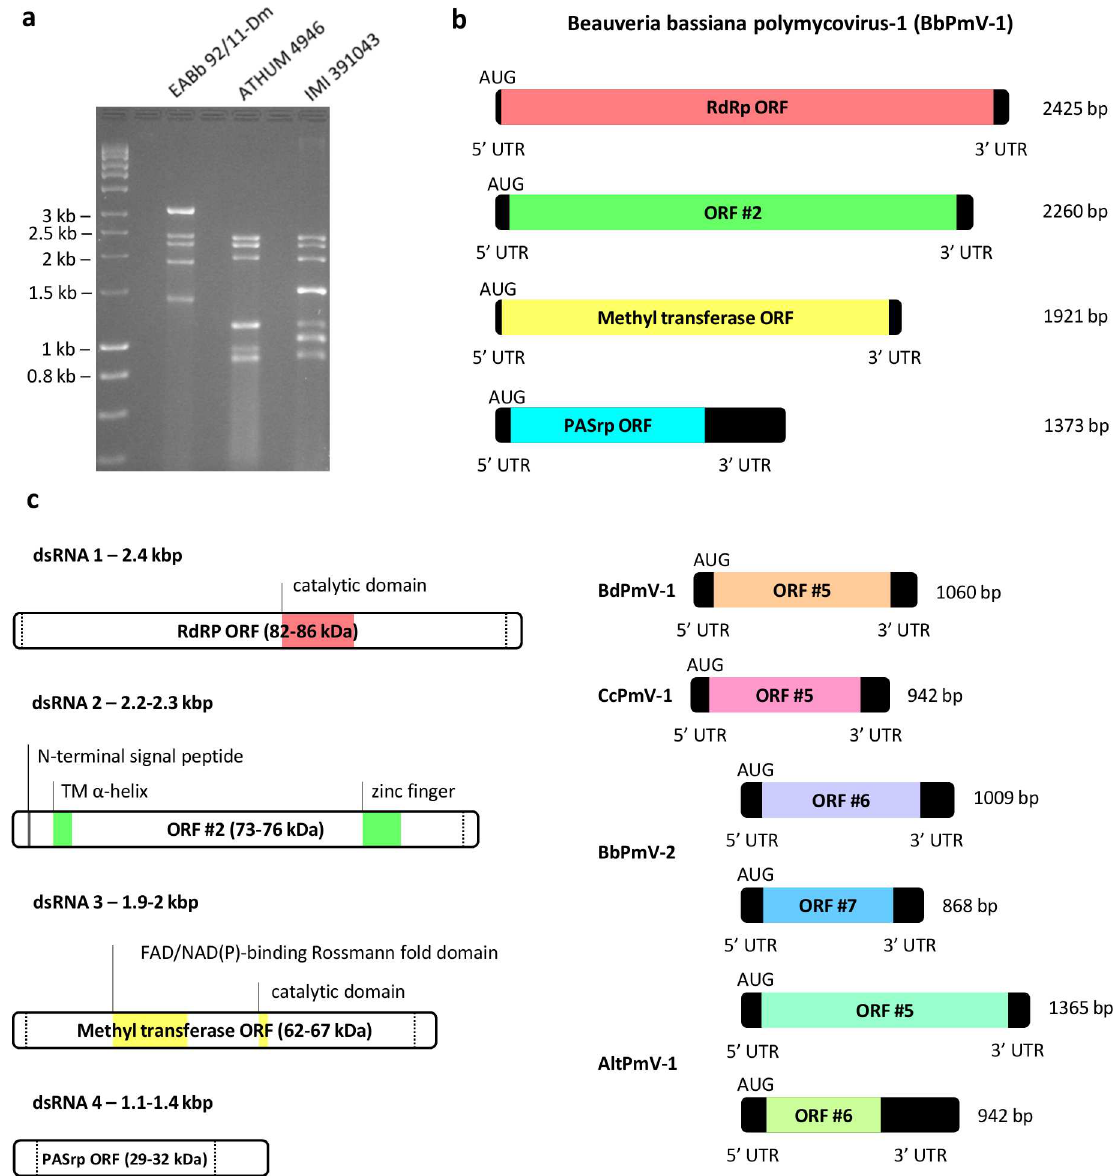
Fig 1. Polymycoviruses in Beauveriabassiana . (a) 1.5% ( w / v ) agarosegel electrophoresis of dsRNA extracted from B . bassiana isolates EABb 92/11-Dm, IMI 391043and ATHUM 4946 harboringBbPmV-1, BbPmV-2 and BbPmV-3 respectively. Lane1 containsthe DNA marker Hyperladder I (Bioline), the sizes of which are shown to the left of the gel. (b) Schematic representation of the genomicorganization of BbPmV-1. The BbPmV-1 genome consist of four dsRNAs, each containing one ORF (grey boxes) flanked by 5’- and 3’-UTRs (black boxes). (c) Schematic representation of the genomicorganization of the proposed family Polymycoviridae illustrating known or predictedfeatures of the proteins encodedby the four major dsRNAs. Additional sequencedelements, uniquefor selectedpolymycoviruses, each containing one ORF (grey boxes) flankedby 5’- and 3’-UTRs (black boxes) are shown and includeBdPmV-1 dsRNA 5, CcPmV-1 dsRNA 5, BbPmV-2 dsRNAs 6 and 7, and AltPmV- 1 dsRNAs 5 and